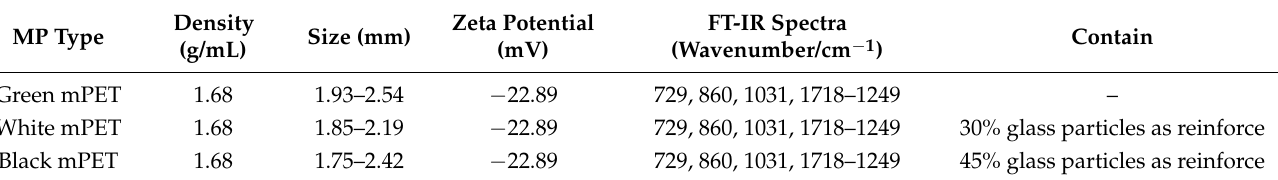
Table 1. Types and characteristics of the selected